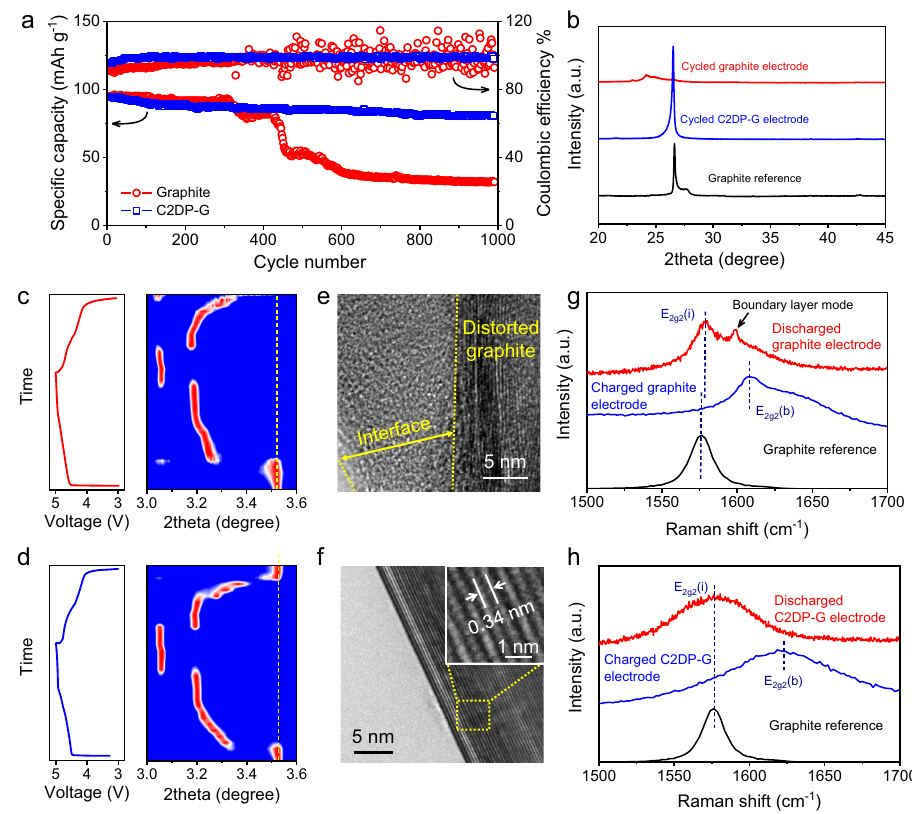
Fig. 4 | Durability assessment of the PF 6 − -intercalation chemistry. a Cycling performanceofthegraphiteelectrodeandC2DP-Gelectrodeat1C. b XRDpatterns ofthegraphiteelectrodeandtheC2DP-Gelectrodeafter1000GCDcyclesat1C. c, d OperandosynchrotronXRDmapsof( c )thegraphiteelectrodeand( d )theC2DP-